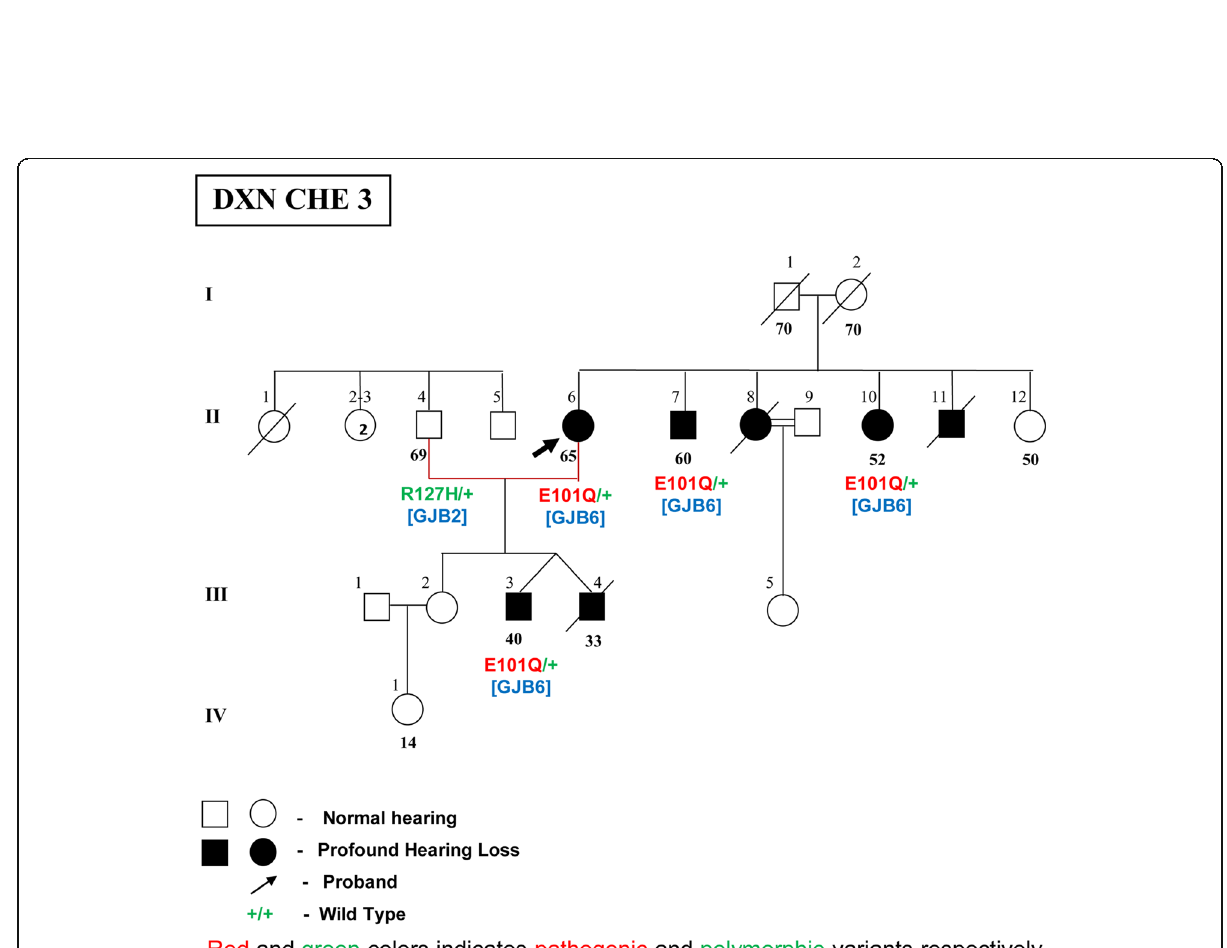
Fig. 5 Pedigree of DXNCHE3 family showing novel mutation p.E101Q in GJB6